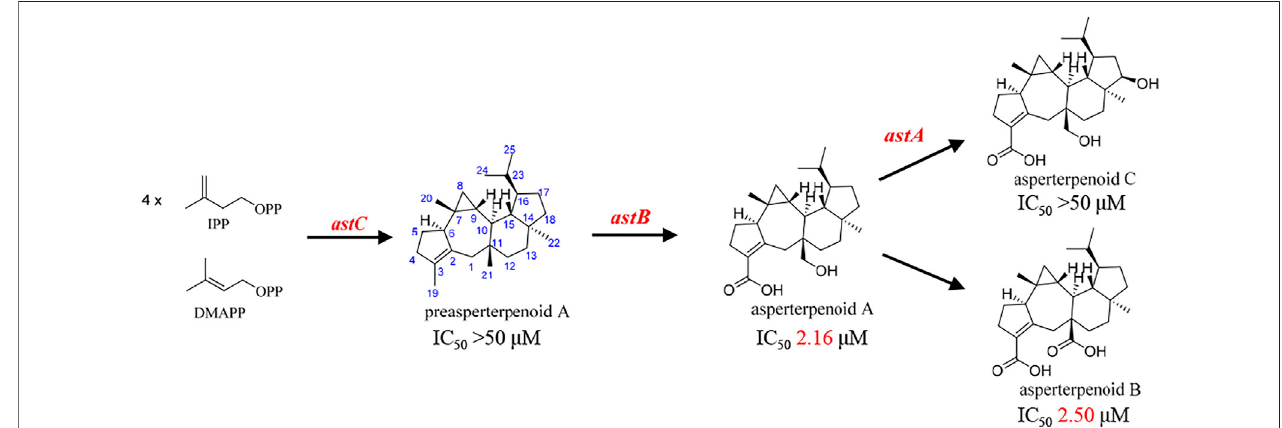
FIGURE 1 | Biosynthesis and IC 50 value ( m PTPB inhibitions) of the reported asperterpenoids.